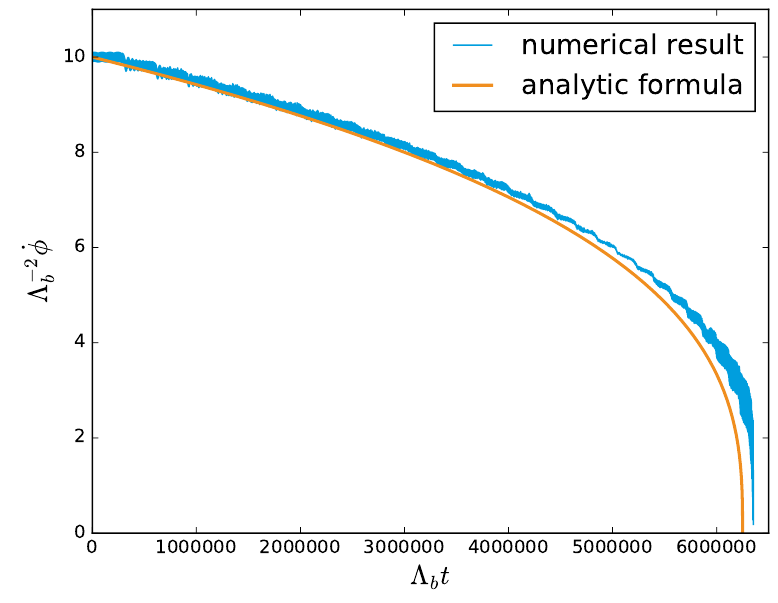
Figure 11 . Time evolution of _ (cid:30) with f = 1000(cid:3) b , _ (cid:30) = 10(cid:3) 2 obtained by solving eqs. (2.9) and (2.10), and the orange line is the solution of eq. (3.24). We take the same parameters as (cid:12)gure 10.